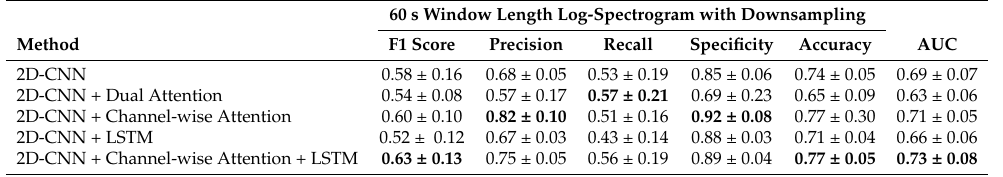
Table 2. Quantitative comparison on the proposed 2D-CNN + Channel-wise Attention method and the baseline method using downsampled log-spectrogram. The results are presented as mean ± standard deviation. The best performance is indicated in